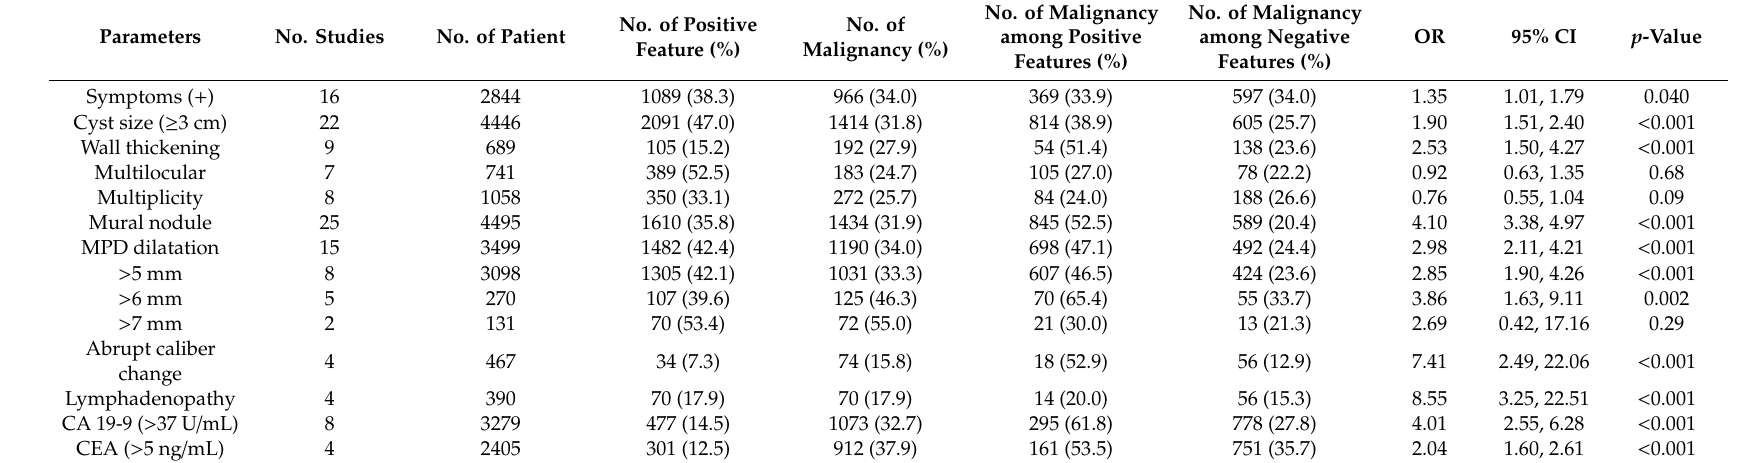
Table 2. Summary of clinical, radiographic, and biochemical